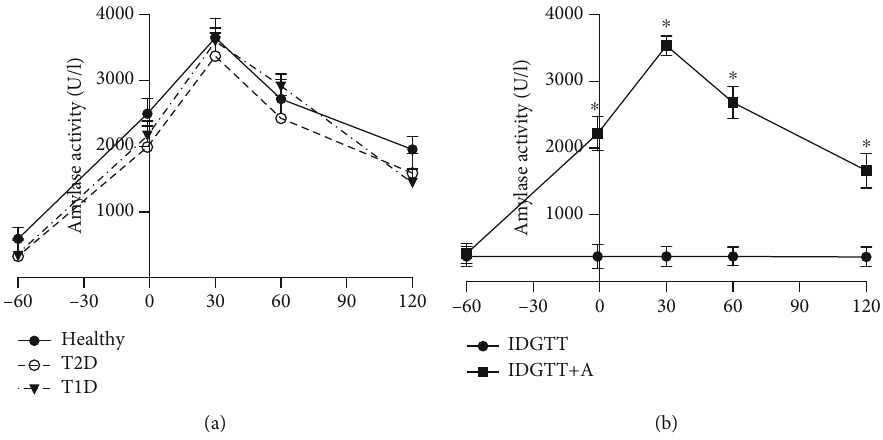
Figure 2: (a) Plasma amylase activity in healthy pigs ( n = 4 ); pigs with STZ-induced type 2-like diabetes mellitus, which were administered STZ at 110mg/kg bw ( n = 4 ); and pigs with STZ-induced type 1-like diabetes mellitus, which were administered STZ at 150mg/kg bw ( n = 4 ) during an intraduodenal glucose tolerance test with an intravenous pancreatic amylase infusion (IDGTT+A). Data were analyzed using Brown-Forsythe and Welch ANOVA tests and are presented as mean ± SD . (b) Plasma amylase activity in experimental animals ( n = 12 ), during an intraduodenal glucose tolerance test (IDGTT), either alone or together with an intravenous pancreatic amylase infusion (IDGTT+A). Data were analyzed using a paired Student t -test and are presented as mean ± SD . ∗ describes signi fi cant di ff erences between IDGTT and IDGTT+A in corresponding time points when p < 0 : 05